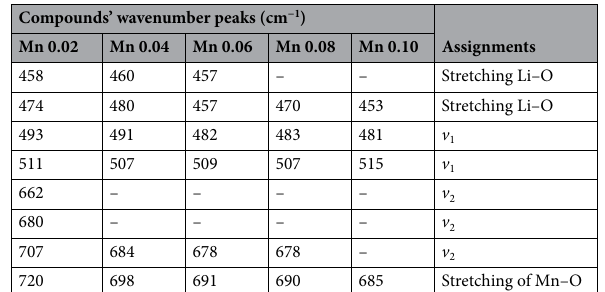
Table 2. Samples’ peaks and their assignments from FTIR characterization.